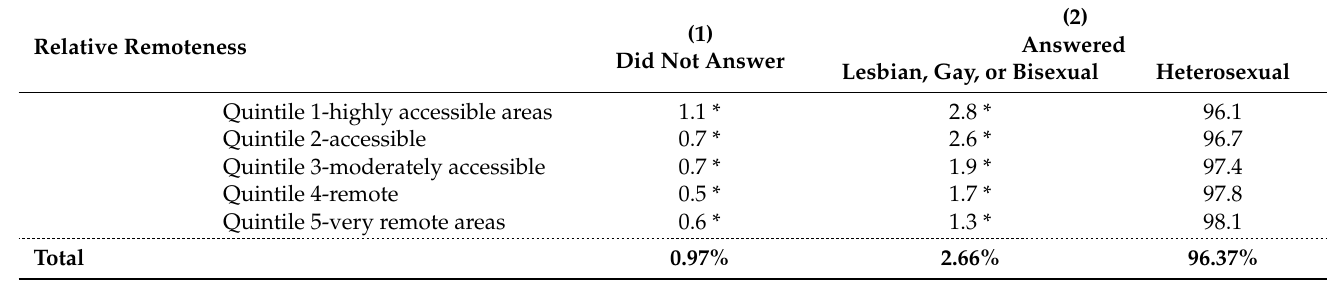
Table 2. Percentage distribution of survey respondents aged 18–59 by their response to the question on sexual identity, according to the remoteness of the residential